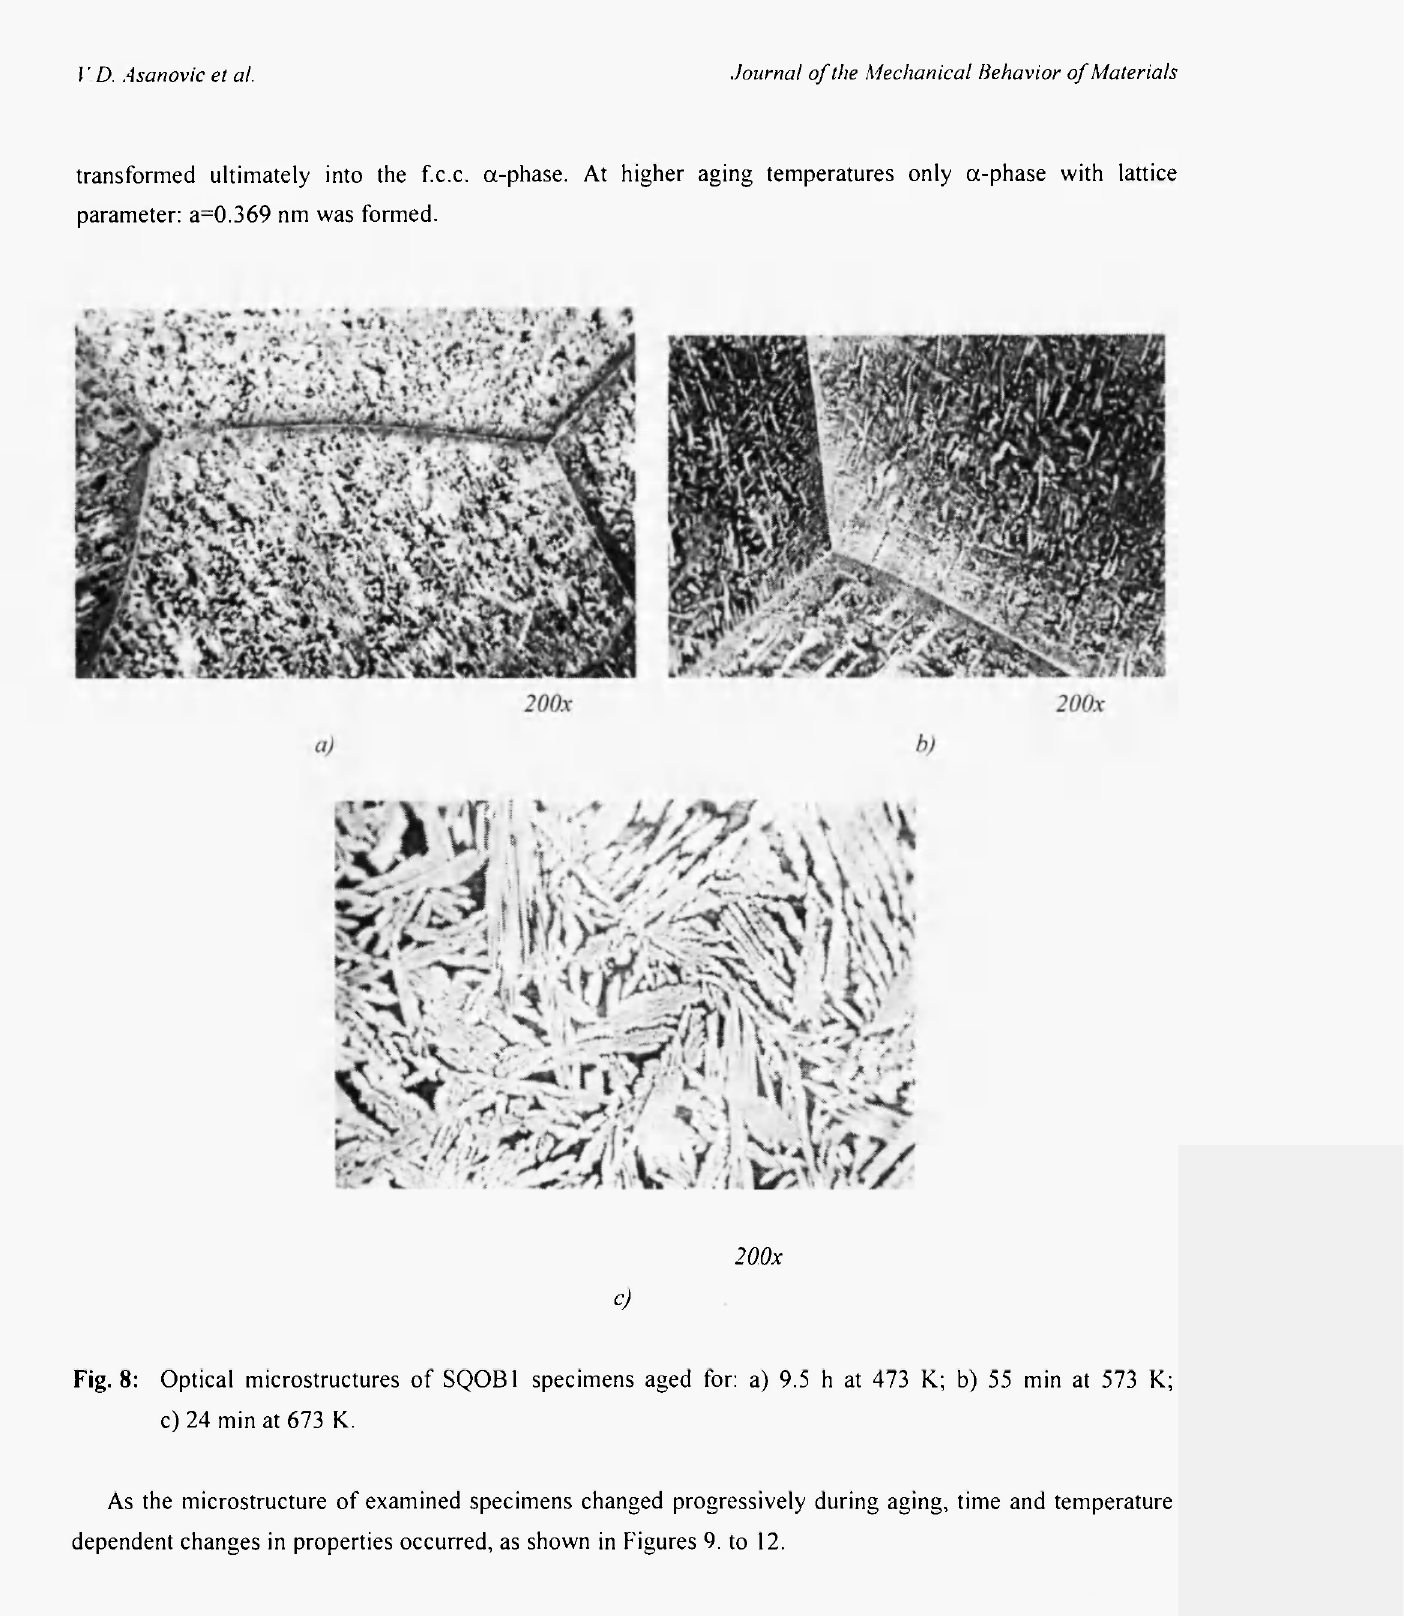
Fig. 8: Optical microstructures of SQOB1 specimens aged for: a) 9.5 h at 473 K; b) 55 min at 573 K; c) 24 min at 673